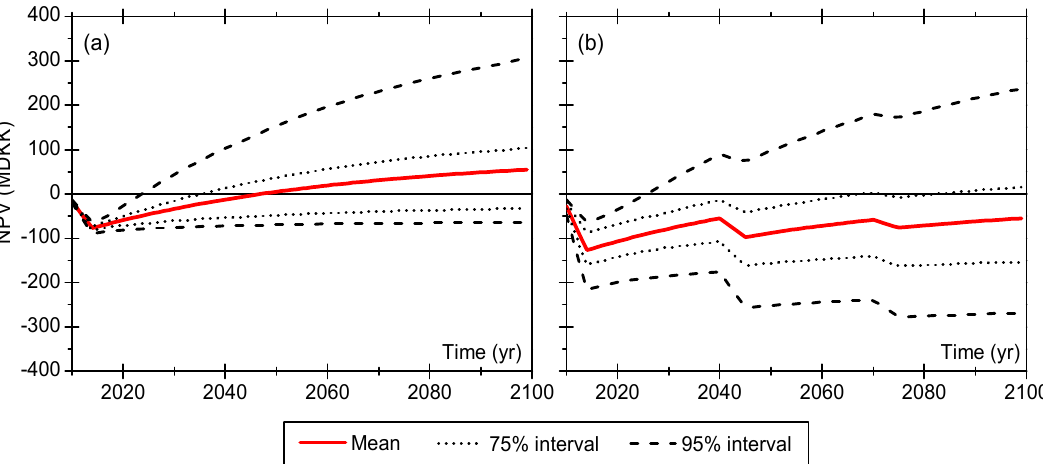
Figure 6. Uncertainty bounds of net benefits of pipe enlargement ( a ) and local infiltrations ( b ) as a function of time.